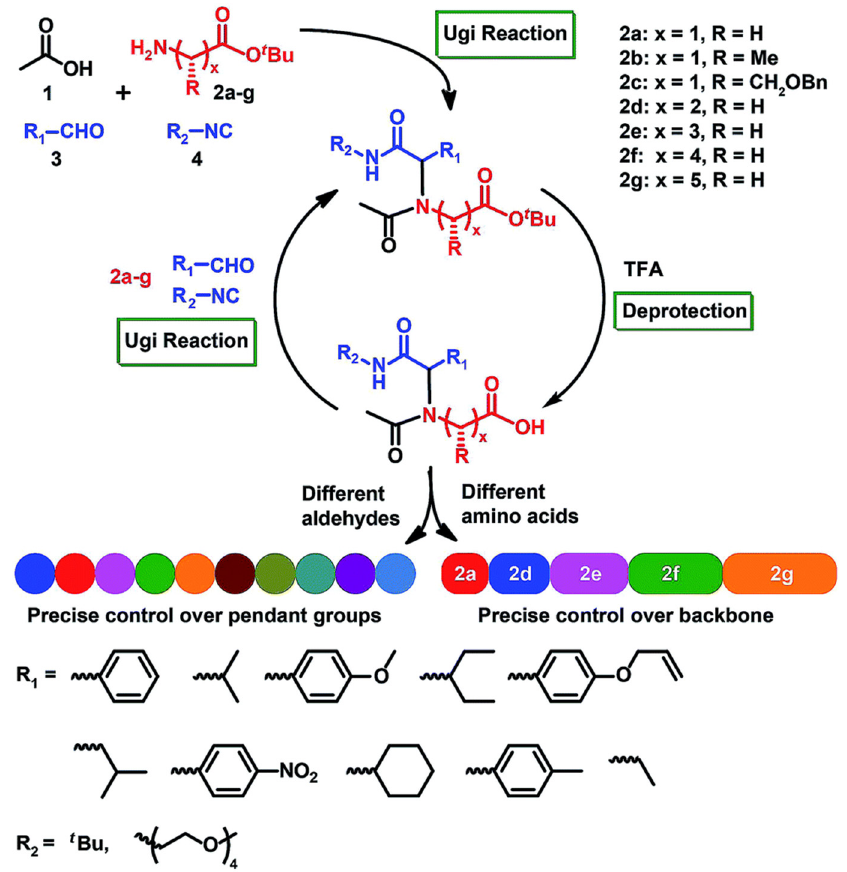
Figure 22. Synthesis strategy towards sequence-defined peptoids via amino acid building blocks and iterative Ugi reactions (Adapted from ref. [119]. Copyright 2019, Royal Society of Chemistry).